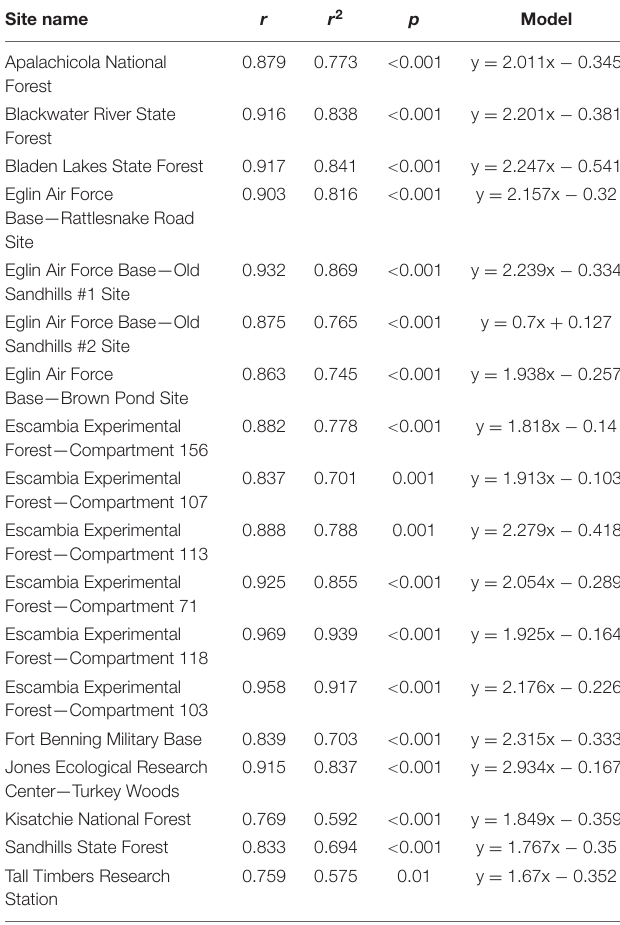
TABLE 2 | Results of the linear models between PBC and log average cone crop for all 18